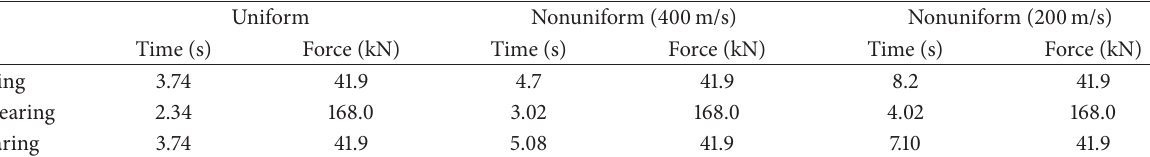
Table 3: Peak responses of shear forces.